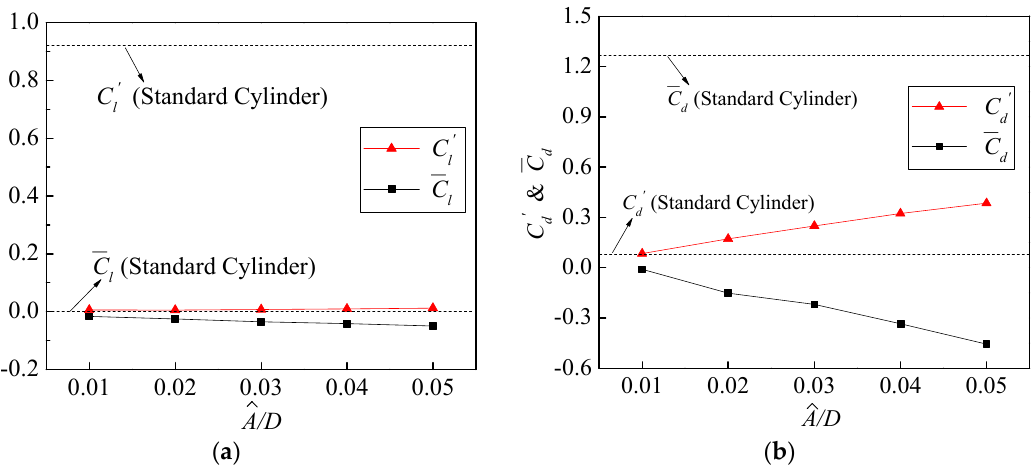
Figure 11. Characteristic values of lift and drag coefficient under different wave amplitudes. ( a )